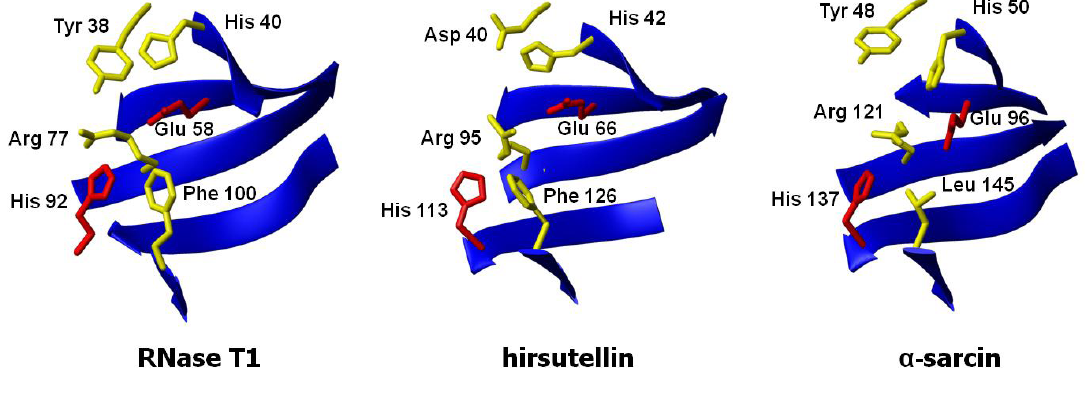
Figure 4. Three-dimensional structures of the active sites (cid:82)(cid:73)(cid:3) (cid:85)(cid:76)(cid:69)(cid:82)(cid:87)(cid:82)(cid:91)(cid:76)(cid:81)(cid:86)(cid:3) (cid:302) -sarcin and hirsutellin A (HtA) and the non-toxic fungal RNase T1. The structures were fitted to the (cid:83)(cid:72)(cid:83)(cid:87)(cid:76)(cid:71)(cid:72)(cid:3)(cid:69)(cid:82)(cid:81)(cid:71)(cid:3)(cid:68)(cid:87)(cid:82)(cid:80)(cid:86)(cid:3)(cid:82)(cid:73)(cid:3)(cid:87)(cid:75)(cid:72)(cid:3)(cid:68)(cid:70)(cid:87)(cid:76)(cid:89)(cid:72)(cid:3)(cid:86)(cid:76)(cid:87)(cid:72)(cid:3)(cid:85)(cid:72)(cid:86)(cid:76)(cid:71)(cid:88)(cid:72)(cid:86)(cid:3)(cid:82)(cid:73)(cid:3)(cid:302) -sarcin (His 50, Glu 96, and His 137) and RNase T1 (His 40, Glu 58, and His 92) and those at homologous positions in HtA (His 42, Glu 66, and His